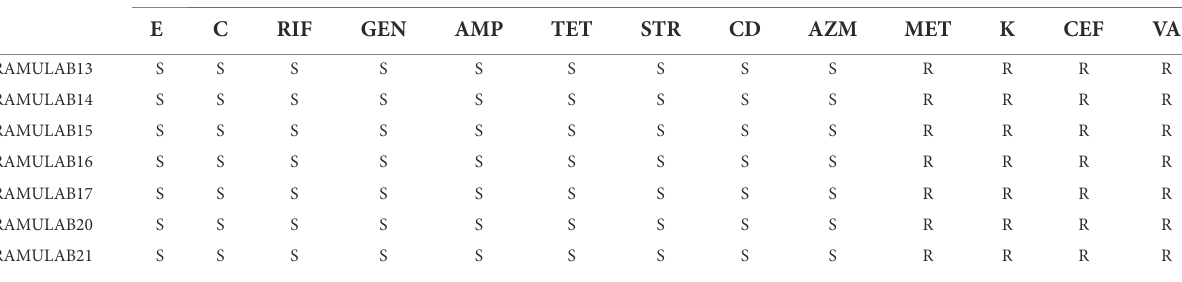
TABLE 4 Antibiotic susceptibility test of the isolates representing resistance and sensitivity based on CLSI, 2018.